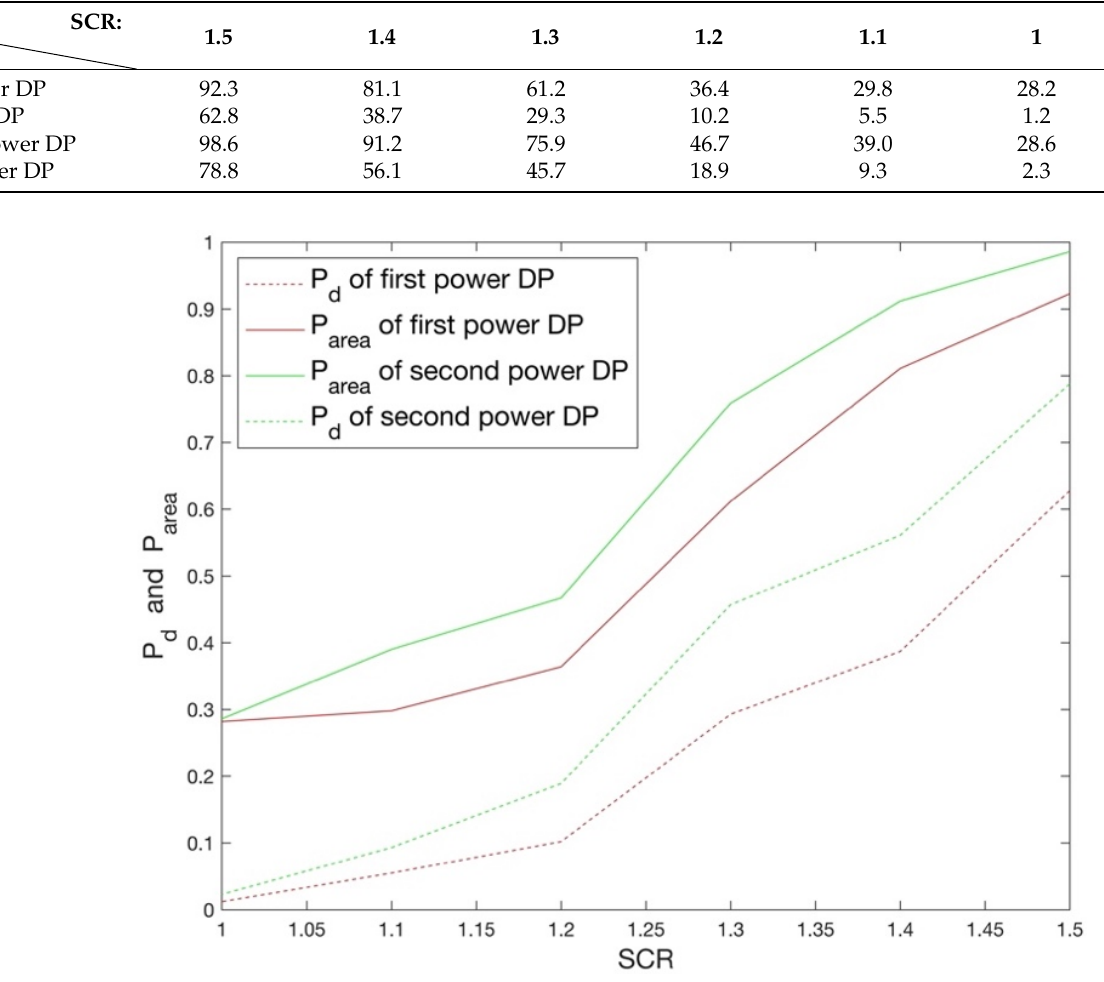
Figure 8. 𝑃 (cid:3028)(cid:3045)(cid:3032)(cid:3028) and 𝑃 (cid:3031) of different method at different